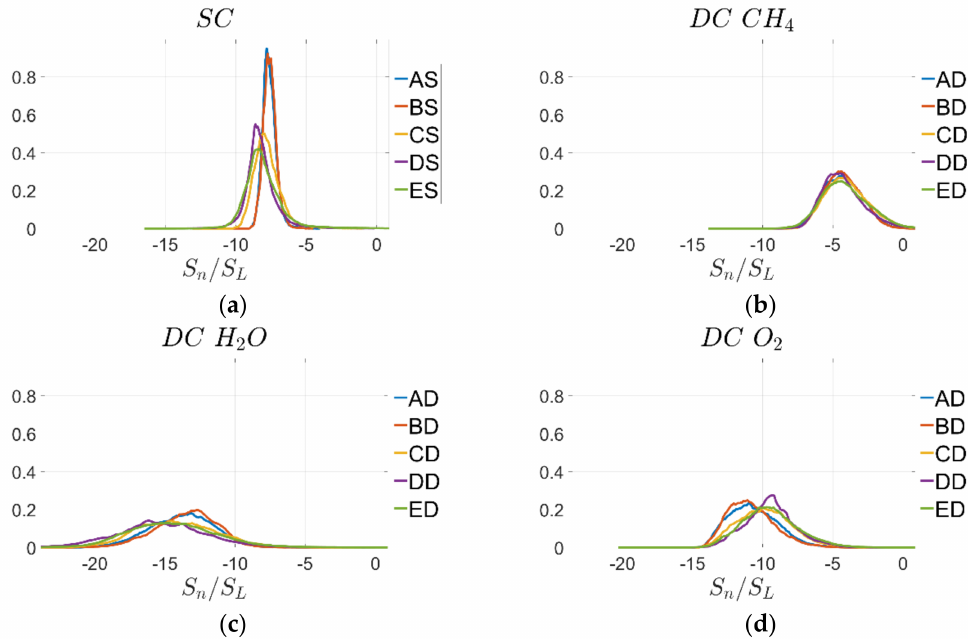
Figure 8. PDF of normalised normal diffusion component of displacement speed S n / S L on c = 0.8 progress-variable isosurface for cases A–E for ( a ) SC and ( b – d ) DC simulations for reaction progress variable based on CH 4 , H 2 O,O 2 mass fractions.